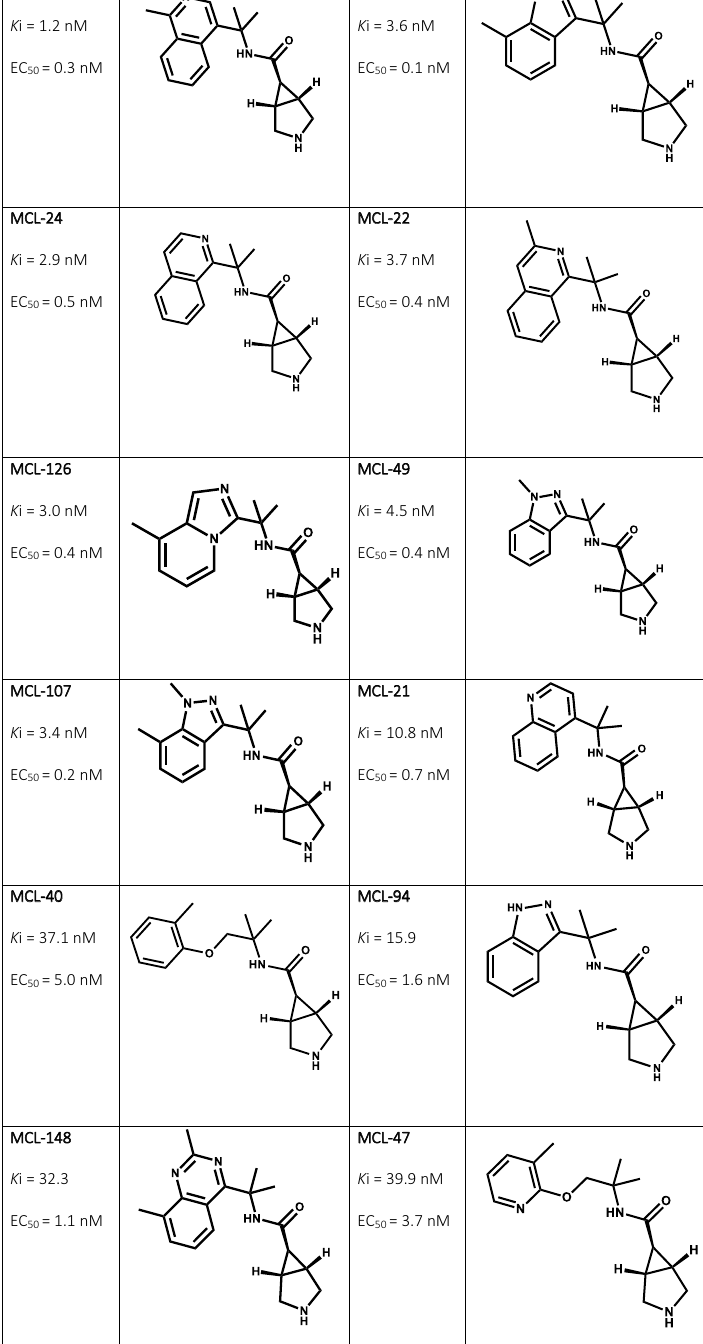
Table 2 Compounds docked into the present model-built sst strucutre and our earlier 4